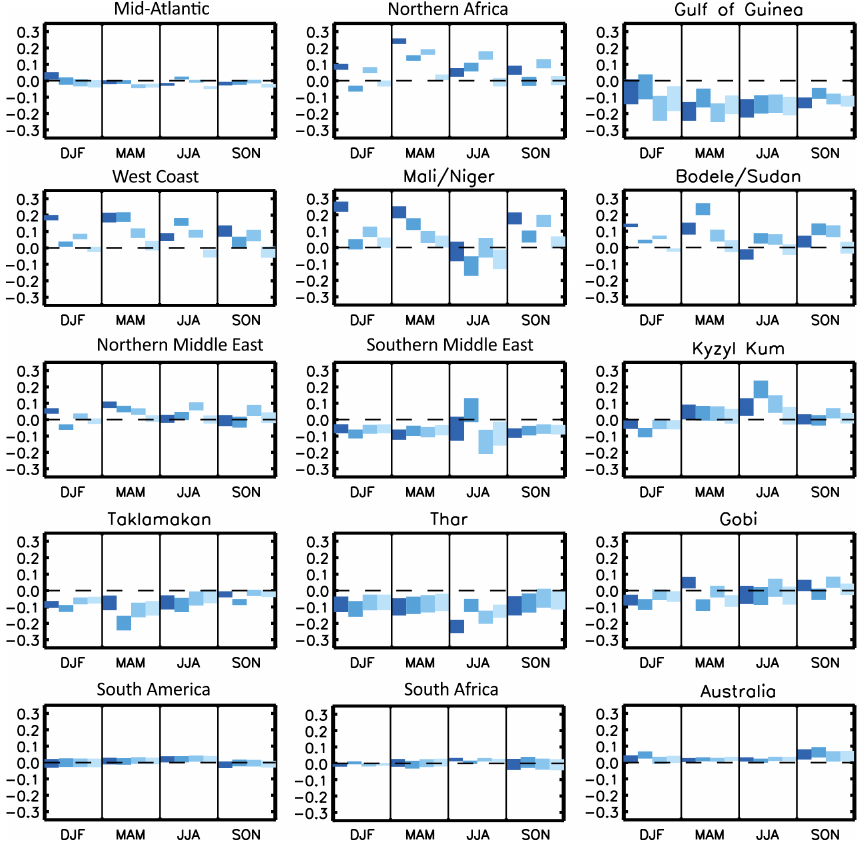
Figure 9. Same as Fig. 7b but for individual regions (in Fig. 1). Models are GEOS-Chem, CESM, WRF-Chem, and MERRAero (dark to light